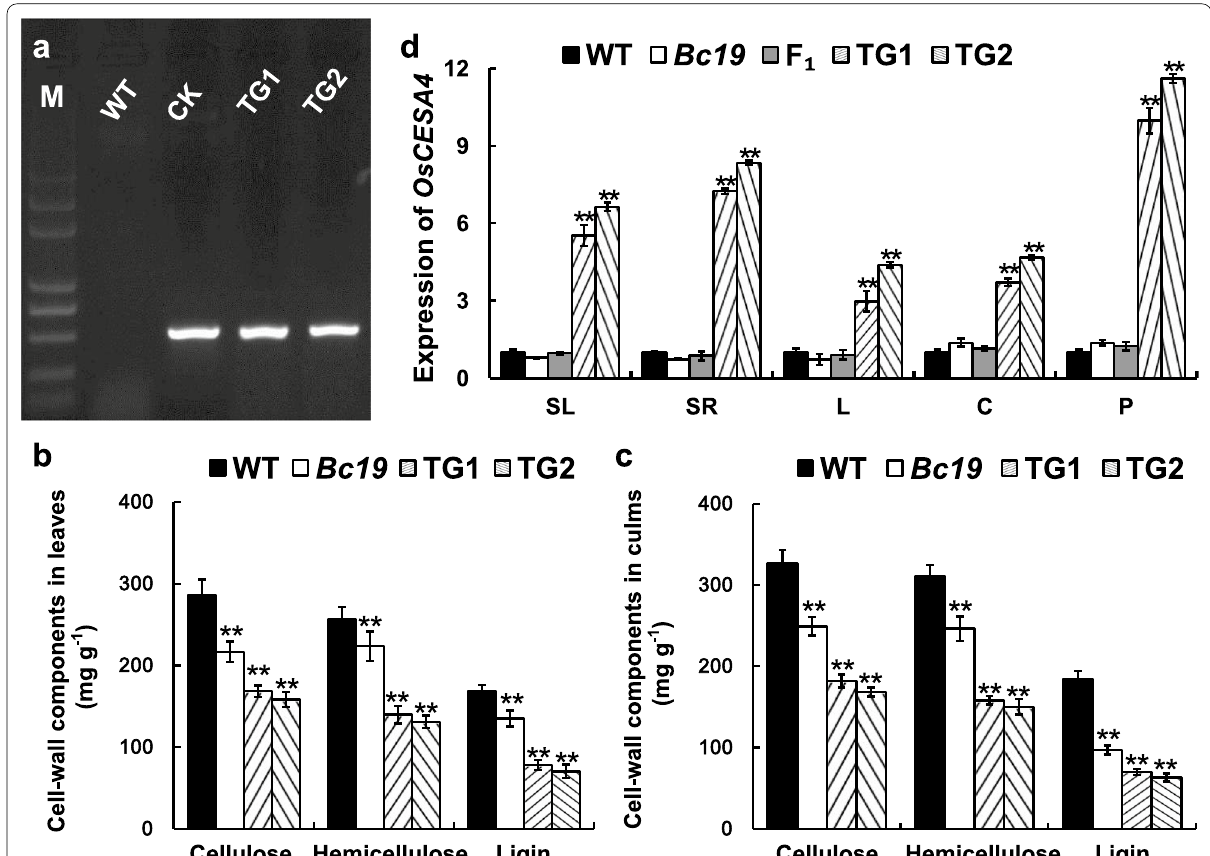
Fig. 5 Functional identification of Bc19 . a PCR assay of transgenic lines of brittle gene Bc19 . M, DL-2000 plus marker; WT, the wild-type parent Nipponbare (the transgenic acceptor, as PCR-negative control); CK, pC2300-Bc19 plasmid (PCR-positive control); TG1 and TG2, positive transgenic lines. b and c Comparison of cell wall components among the wild type plant, mutant Bc19 and two positive transgenic lines, in leaves and culms, respectively. d Transcript levels of OsCESA4 in different tissues of the wild type (WT), the mutant Bc19 , the hybrid F 1 plants from a cross between WT and Bc19 , and two transgenic lines (TG1 and TG2), respectively. SL, seedling leaves; SR, seedling roots; L and C, leaves and culms from plants two weeks after heading, respectively; P, young spikelets. The expression data of WT were all set to 1.0 and those of other plants were adjusted accordingly. Bars represent standard deviations of three independent experiments. Double asterisks signify statistically significant differences compared to WT at p < 0.01